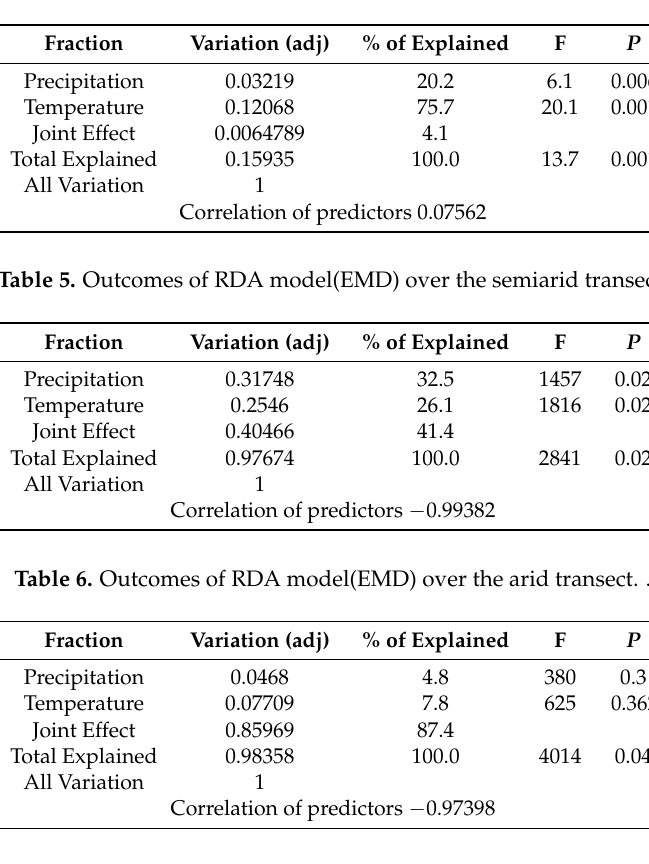
Table 4. Outcomes of RDA model (Original) over the arid transect.